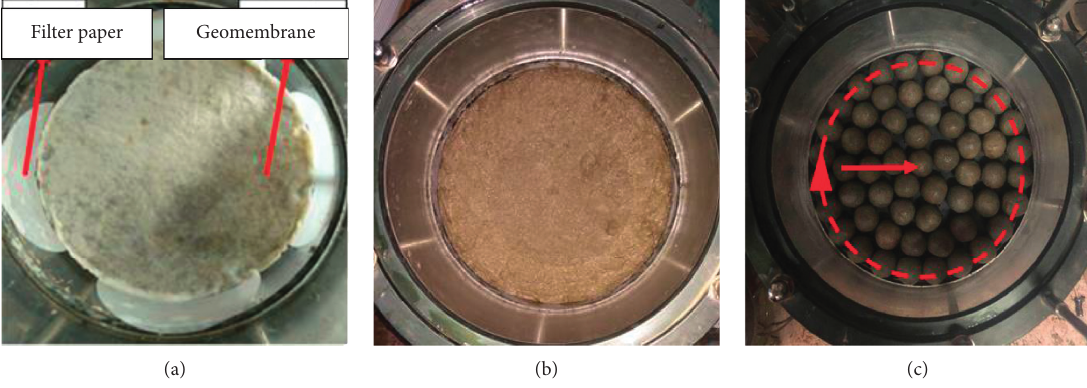
Figure 5: Sample installation processes: (a) installation of filter papers and the geomembrane; (b) clay layer; (c) cement particle filling process.